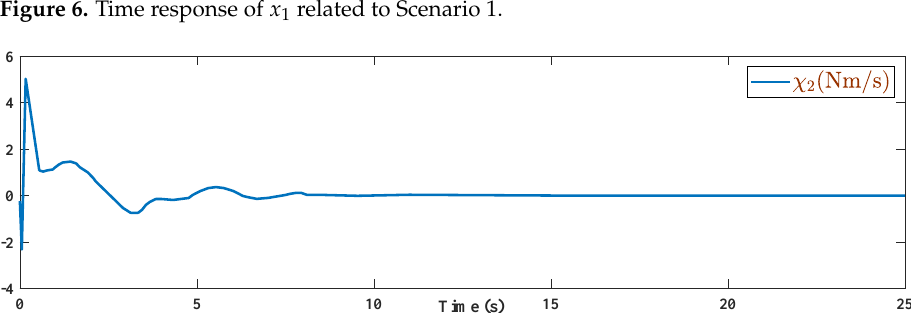
Figure 6. Time response of x 1 related to Scenario 1.